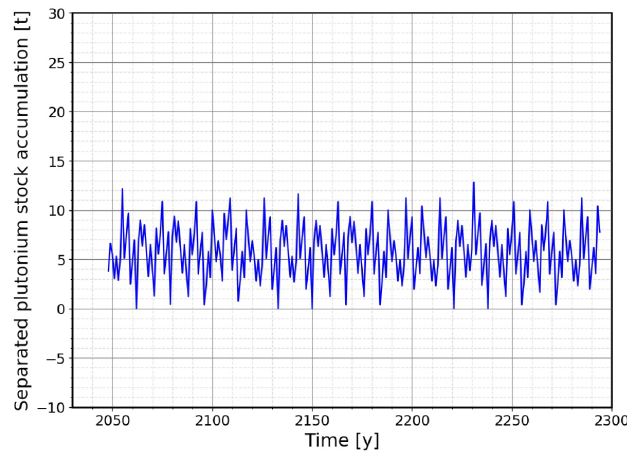
Fig. 8. COSI6 UOX - MIX Pu stock accumulation. Table 6. COSI6/SEPAR comparison of fresh MIX